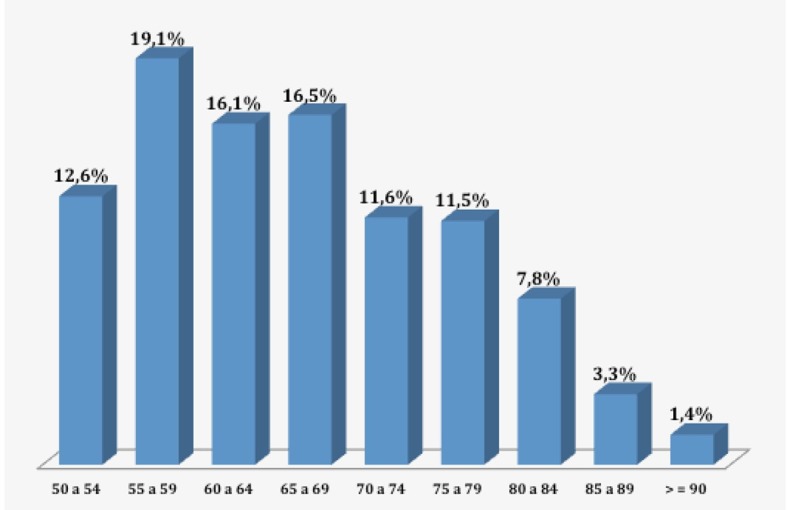
Distribuição quanto à faixa etária da amostra. Fonte: Banco de dados utilizado na pesquisa.